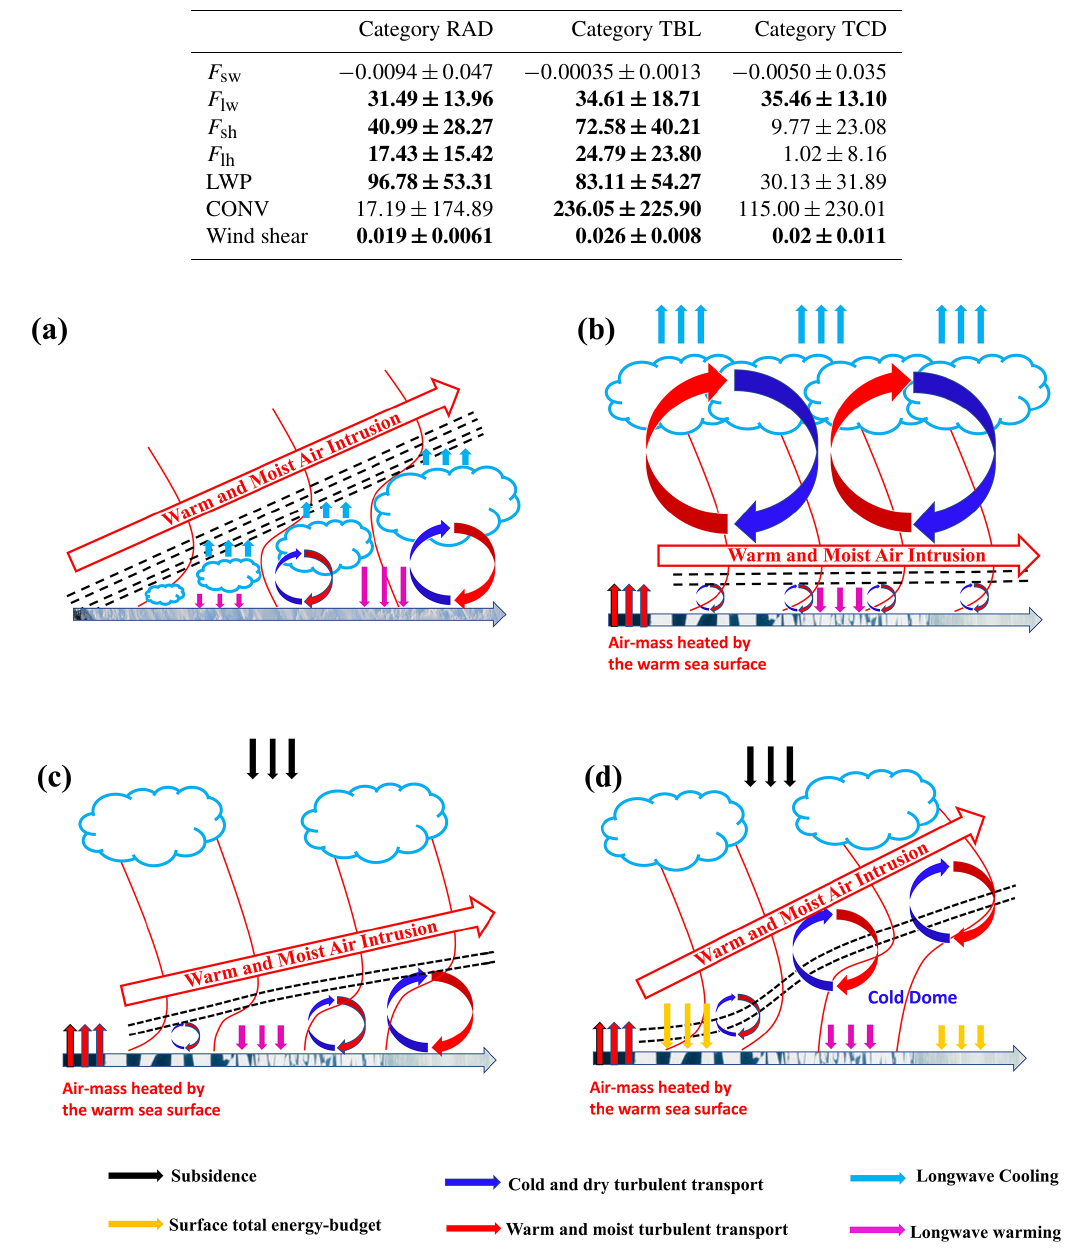
Figure 15. Concept graph of WaMAI from category (a) INV, (b) radiation-dominated WaMAI, (c) turbulence-dominated WaMAI, and (d) turbulence-dominated WaMAI with cold dome. The red lines in (a, b, c) are temperature or humidity profiles. Red arrows represent the WaMAIs. The horizontal arrows represent the Arctic surface with frozen or melting sea ice. Black lines represent